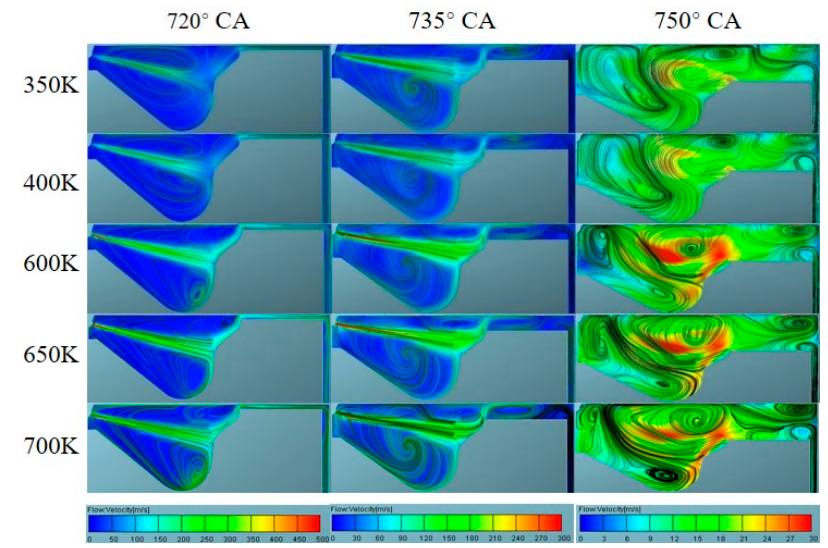
Figure 8. Flow velocity distribution in the cylinder under five operating conditions.